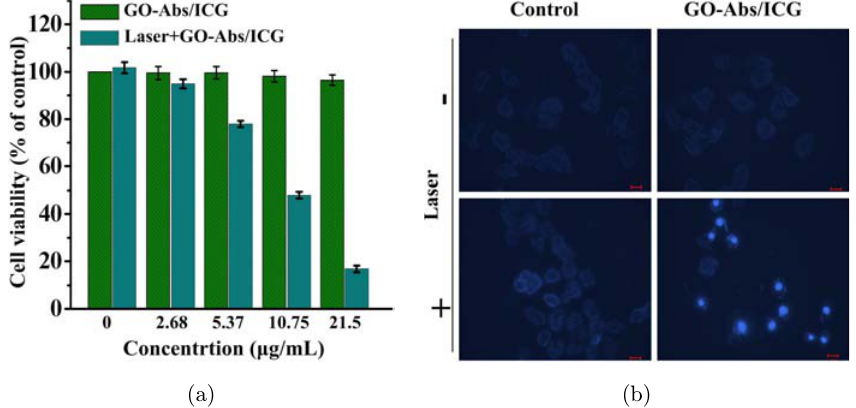
Fig. 4. The photoacoustic therapeutic e®ect of GO-Abs/ICG on U87-MG cell. (a) Cell toxicity test under the di®erent doses of GO-Abs/ICG ( n ¼ 4). The concentrations of GO-Abs/ICG are ranging from 2.68 (cid:4) g/mL to 21.5 (cid:4) g/mL. The laser energy density using in photoacoustic therapy is 16 mJ/cm 2 . (b) After photoacoustic therapy, U87-MG cells apoptosis are evaluated by Hoechst 33258 morphological examination.